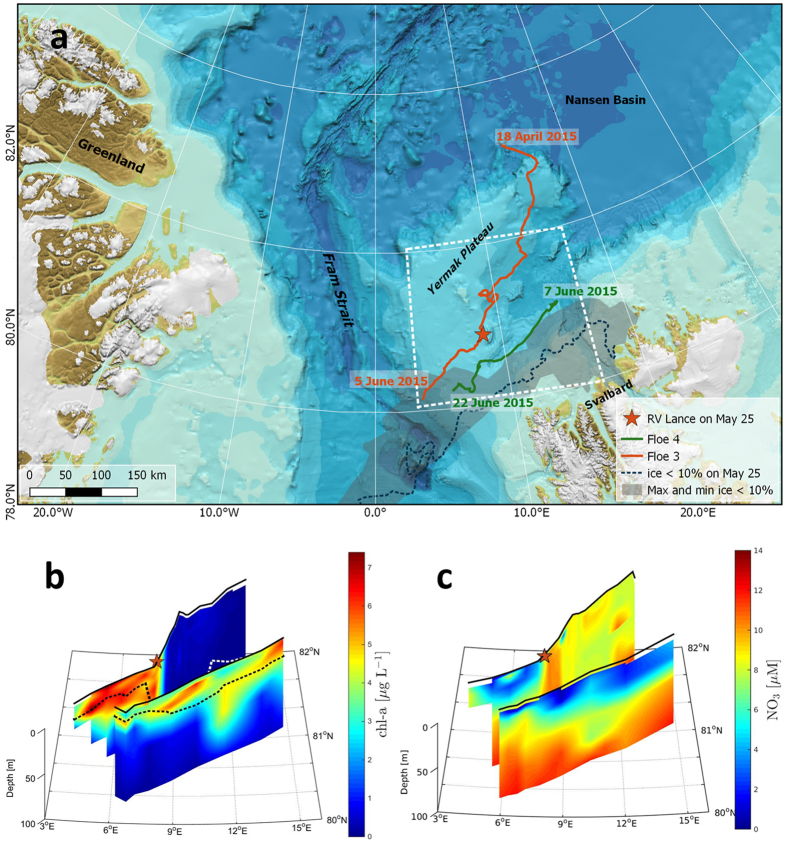
Study location and vertical and spatial extent of the under-ice bloom.(a) European Arctic with bathymetry. Orange and green lines are the drift trajectories of floes 3 and 4, respectively, with start and end dates. The location when we first drifted into the under-ice bloom on 25 May is indicated with an orange star. The area demarcating the ice-edge positions between April and June 2015 is shaded in grey. The ice-edge position on 25 May is indicated by the broken blue line and is representative for the bloom period. We define the ice edge as the outer perimeter of a polygon where ice concentration is >10%. The white outline demarcates the area shown in panels b and c. Map created by the Norwegian Polar Institute, Max König with permission from IBCAO47. Drift trajectories of floes 3 and 4 showing (b) Chlorophyll a, and (c), nitrate concentrations for the upper 100 m of the water column. The dashed line in (b) indicates depth of the pycnocline.